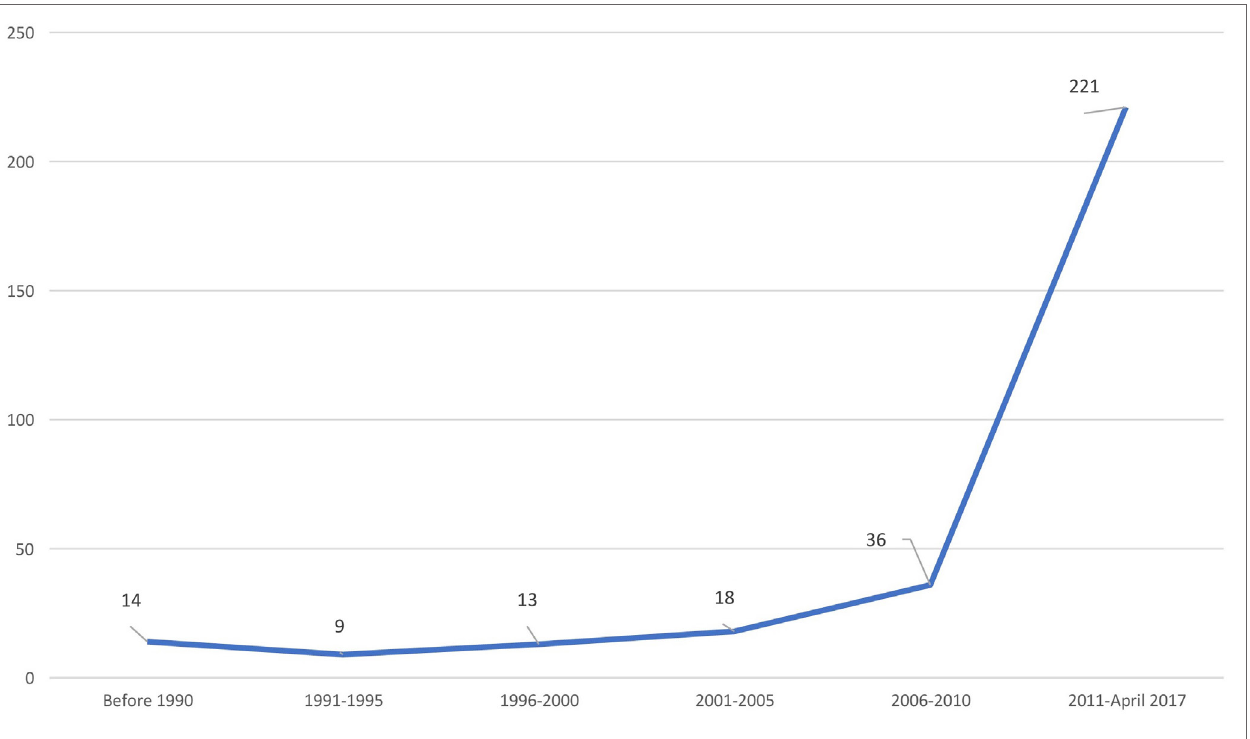
FigUre 1 | Publications on PIDs from